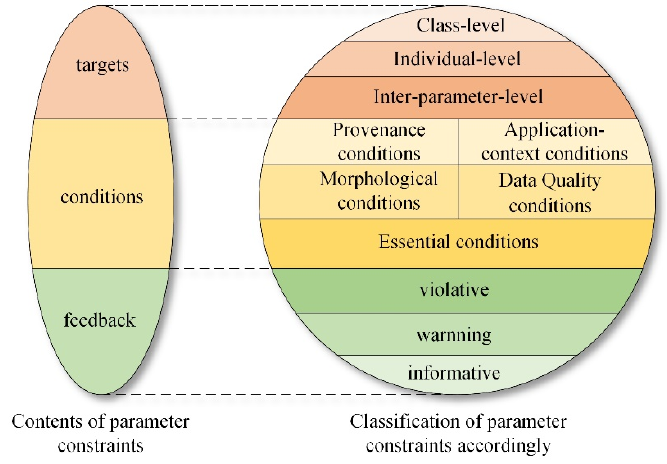
Figure 2. Classification of parameter constraints according to their contents.